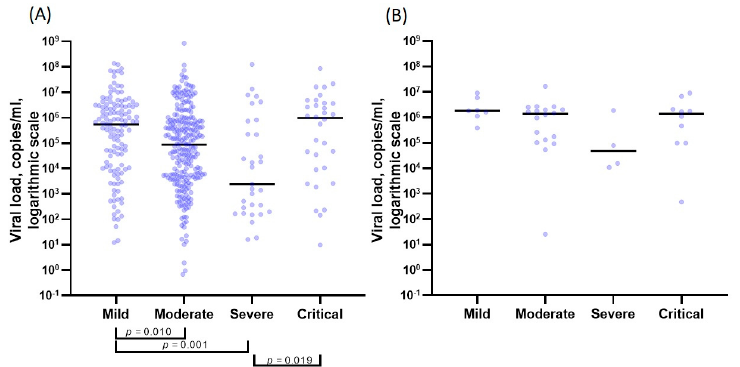
Figure 1. Viral load (copies/mL) depending on the severity of the disease and the strain. ( A ) Omicron strain; ( B ) Delta strain. A higher viral load was noted for the Delta variant. However, statistically significant differences were found only for moderate cases. The viral load of the Delta variant in this load for the Delta variant was 1.37 × 10 6 , p = 0.010, Mann–Whitney test). The Delta variant